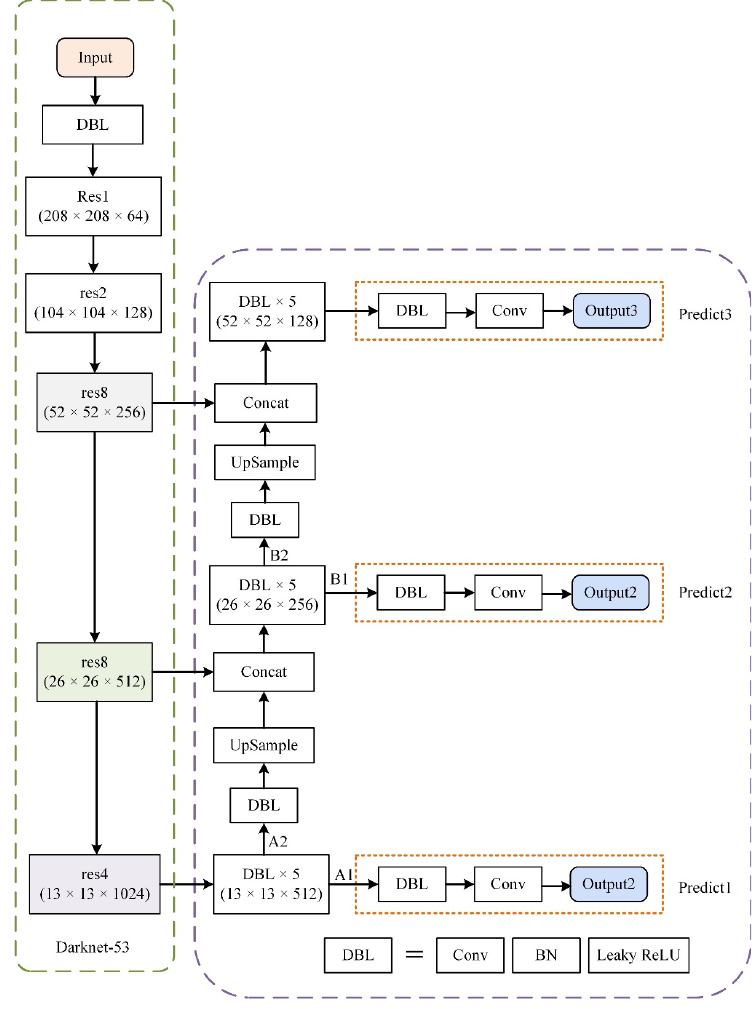
Figure 1. YOLOv3 network structure.